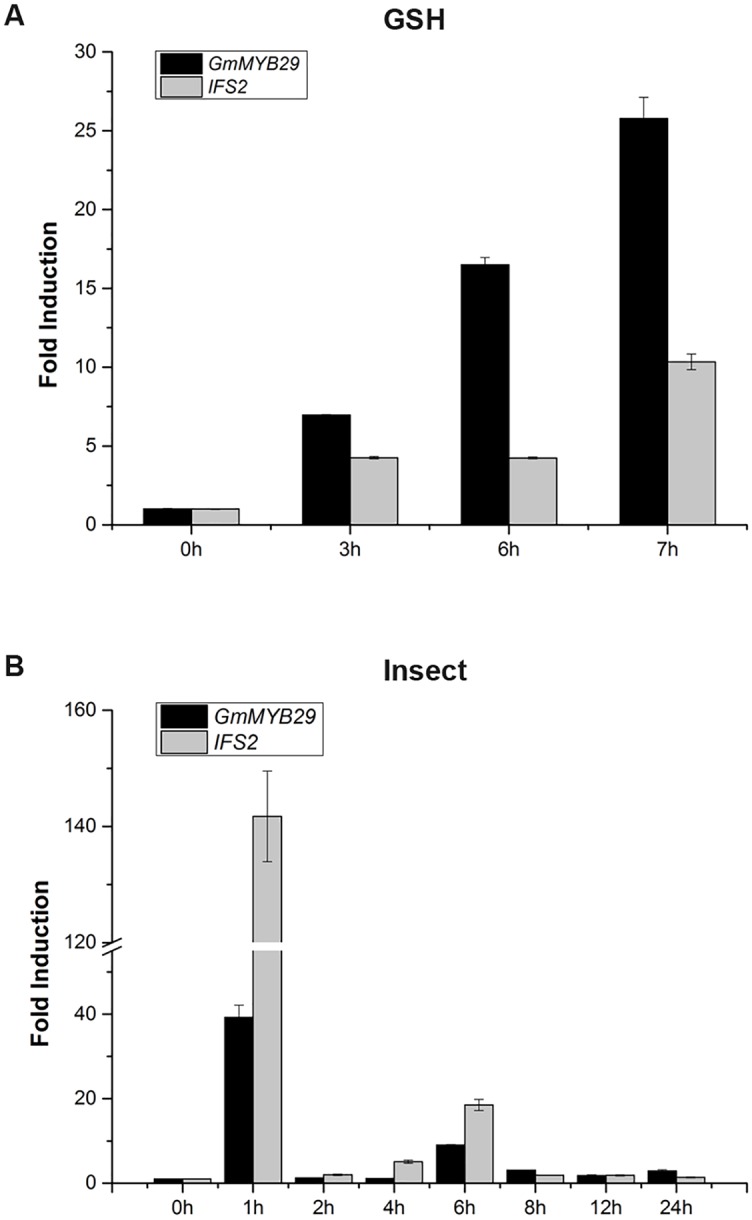
Expression of GmMYB29 and IFS2 in response to glutathione (GSH) and insect treatments.(A) Expression of GmMYB29 and IFS2 in response to GSH treatment. (B) Expression of GmMYB29 and IFS2 in response to insect treatment. The experiment was repeated twice with the same results. The results of one of these experiments are shown. Bars indicate the standard errors of three technical replicates.